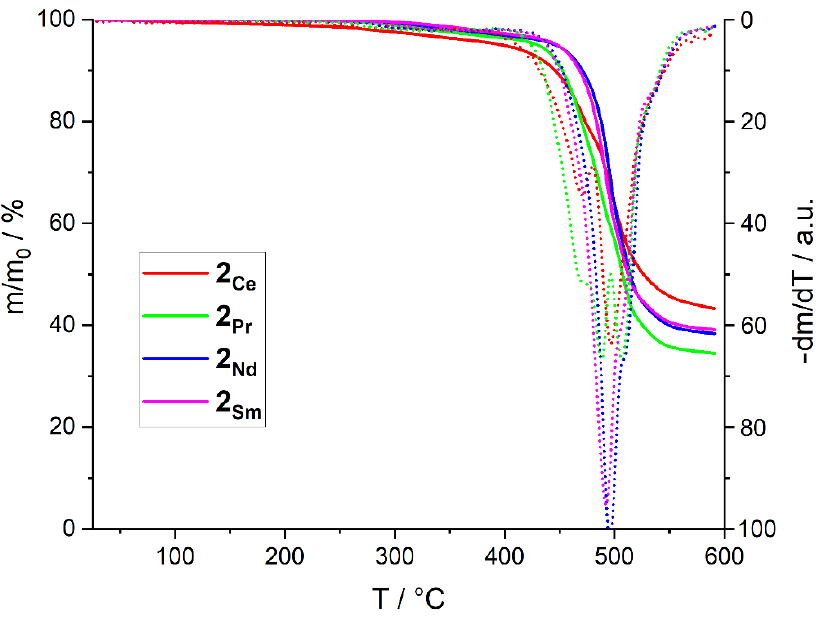
(cid:48) , 2 Ln (solid) and relative dm/dT